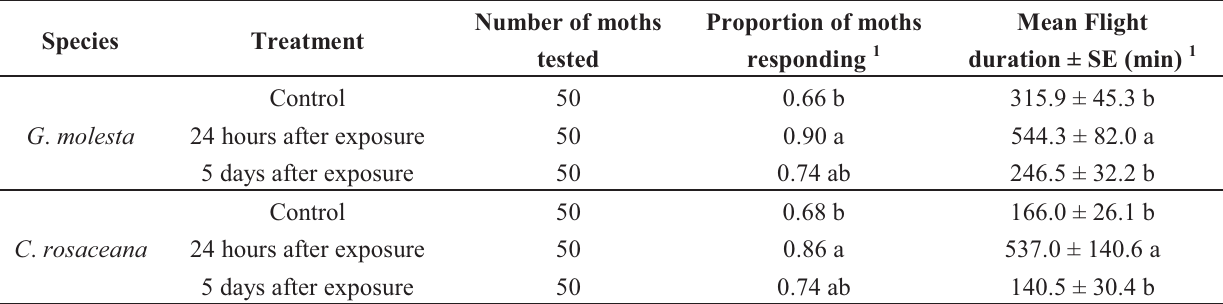
Table 1. Effect of sex pheromone exposure on female flight of Grapholita molesta and Choristoneura rosaceana on a laboratory flight mill 24 hours or 5 days following prolonged